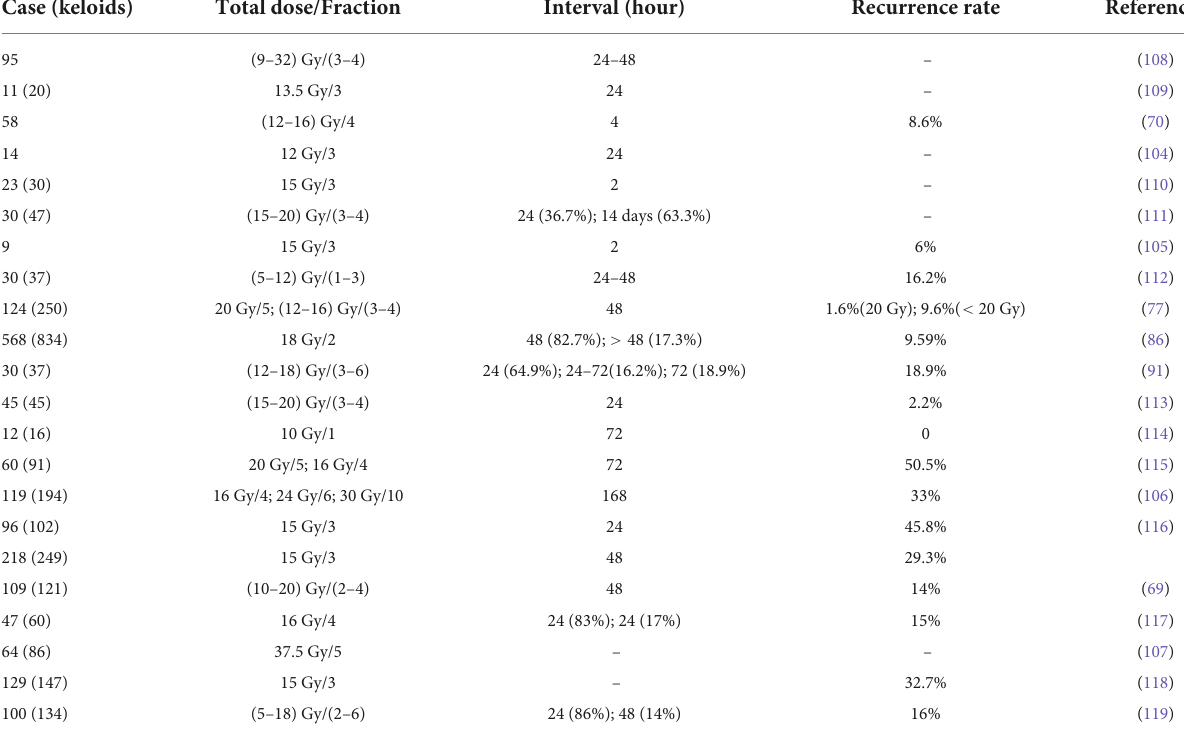
TABLE 2 Dose fractionation and recurrence rate of electron beam for